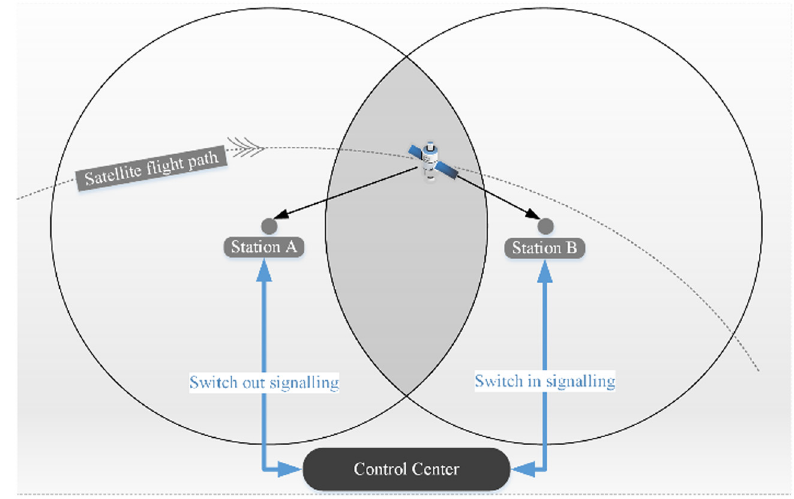
Figure 6: Diagram of handover across two TT&C ground stations.